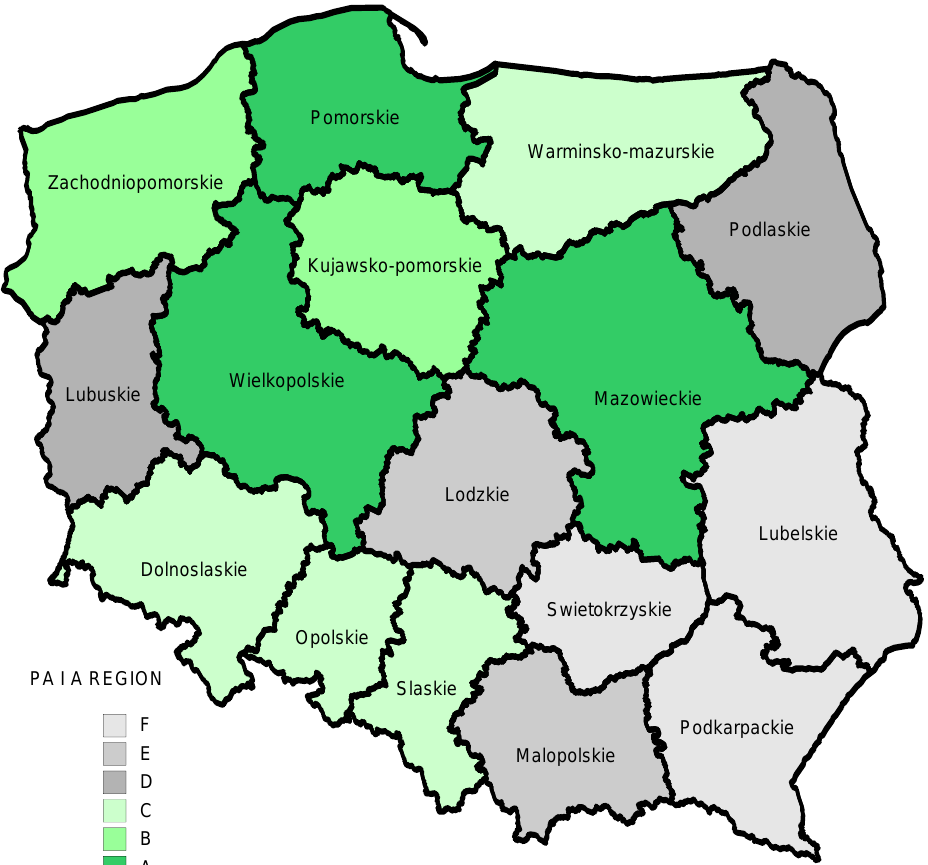
Figure 3. Spatial diversification of the potential investment attractiveness index for Section A enterprises at the regional level (voivodeships) in Poland in 2019 (PAI A REGION). More about the regions of Poland: https://www.paih.gov.pl/publications/regions. (accessed on 30 April 2021). Source: own research (using the program Map Viewer).